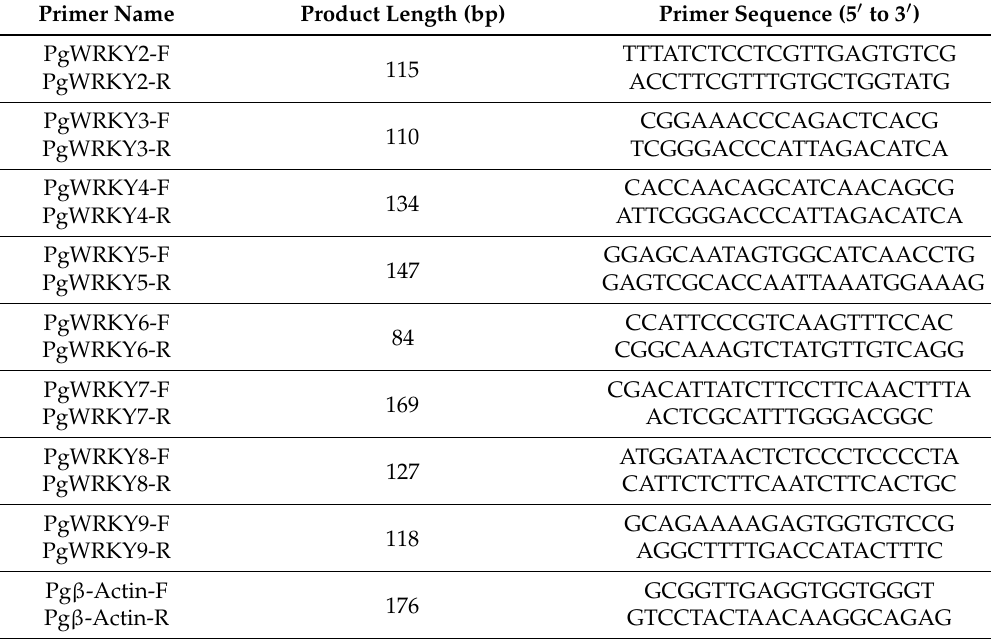
Table 3. List of primers of eight PgWRKYs ( PgWRKY2-9 ) and Pg β -actin used for qRT-PCR